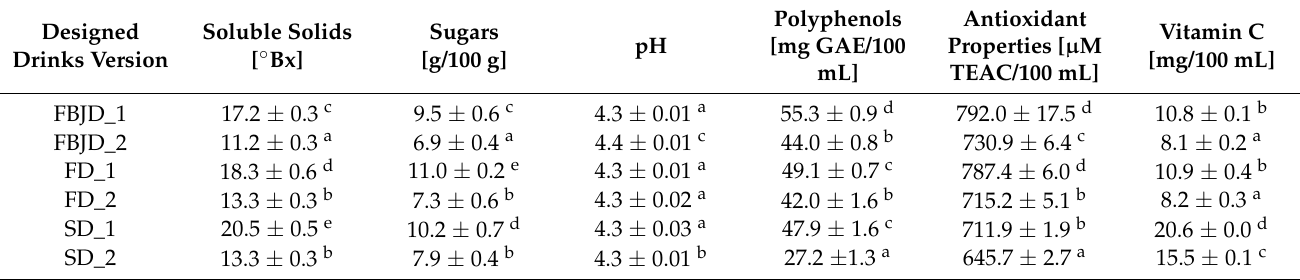
Table 3. Physicochemical and bioactive properties of the designed recovery